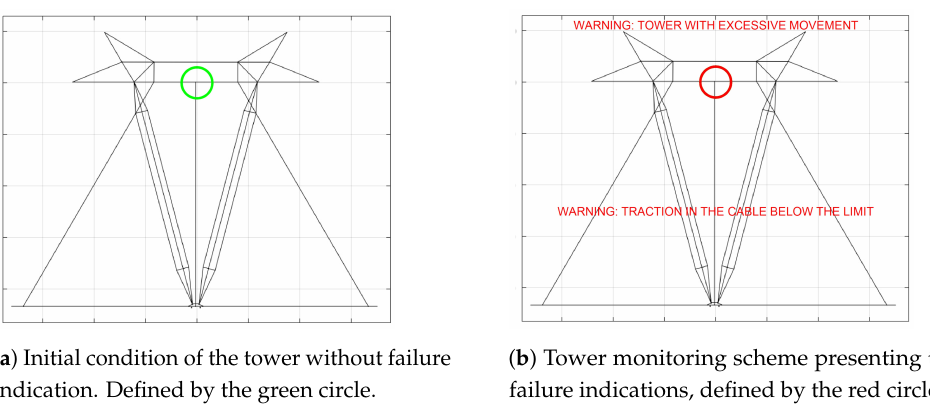
Figure 24. Schematic images of the tower for the status